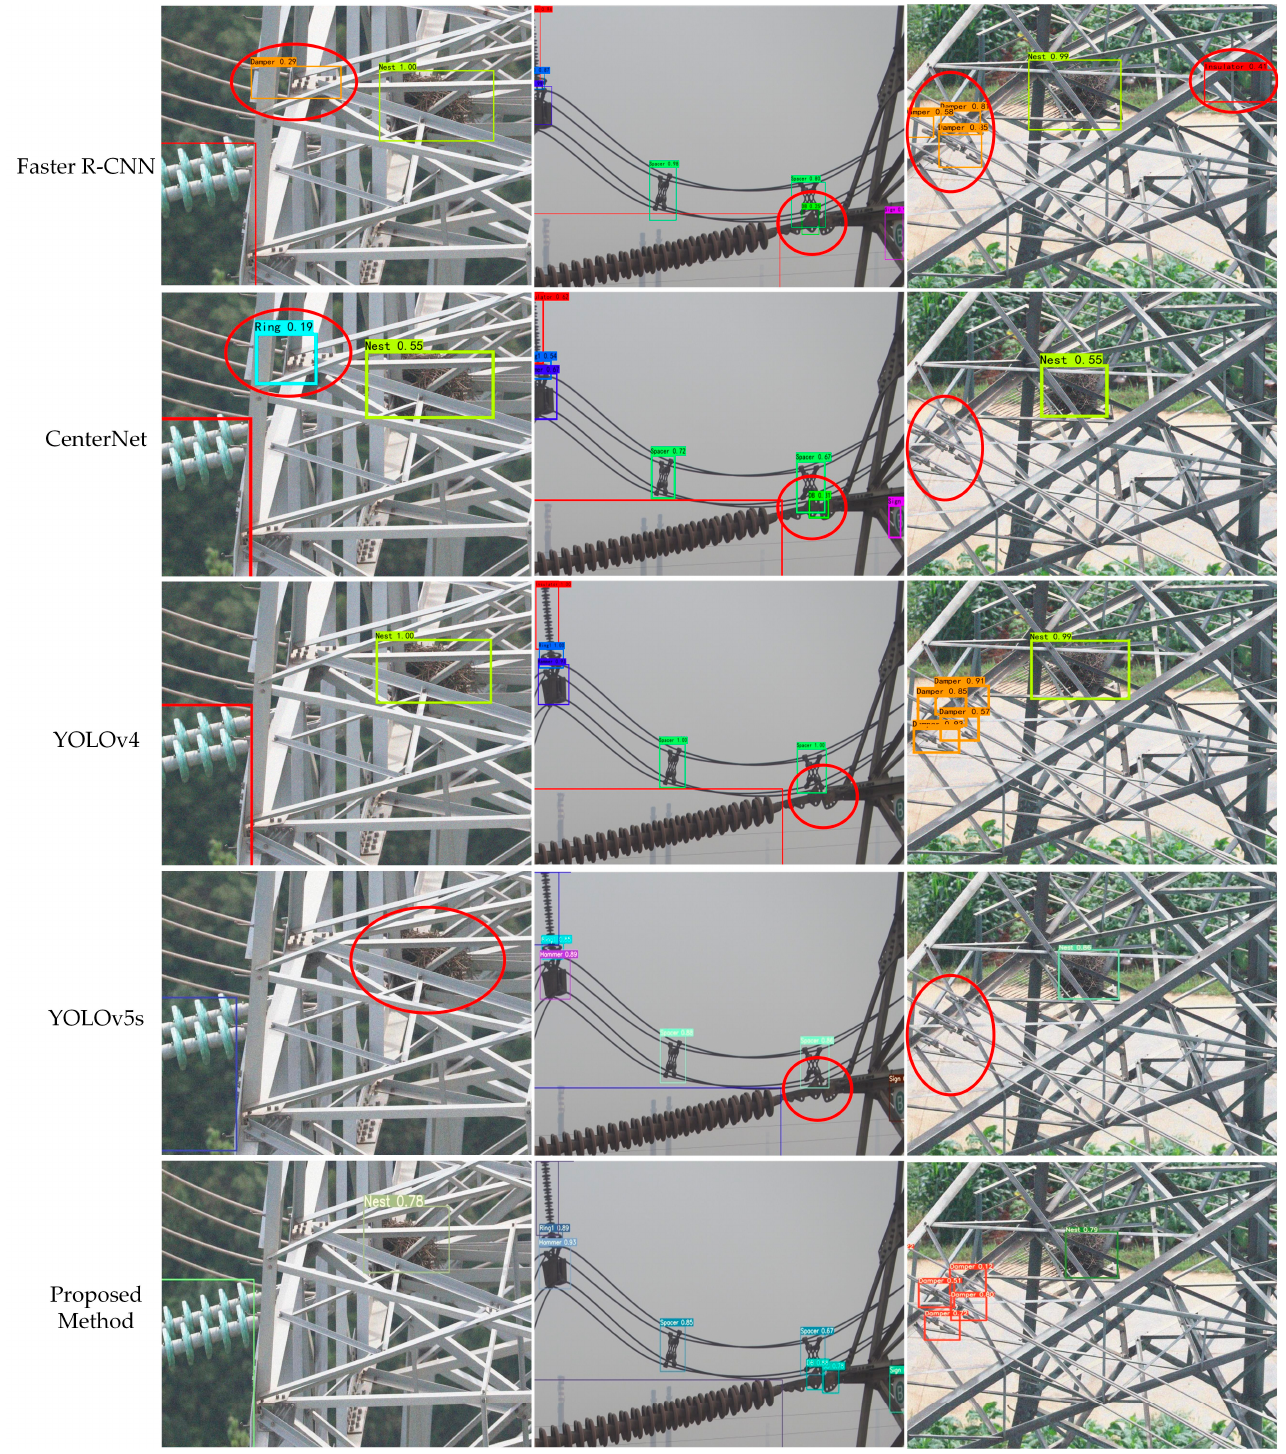
Figure 14. Comparison of detection results of mainstream algorithms.